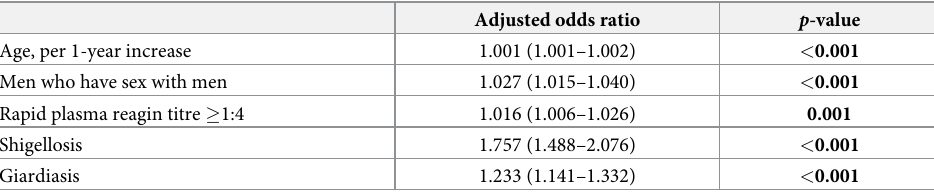
Table 2. Multivariable analysis of factors associated with invasive amoebiasis.